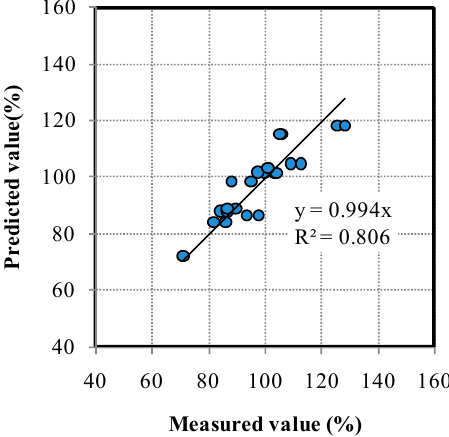
Figure 14. Comparison of the experimental and predicted values of the relative dynamic modulus of elasticity.